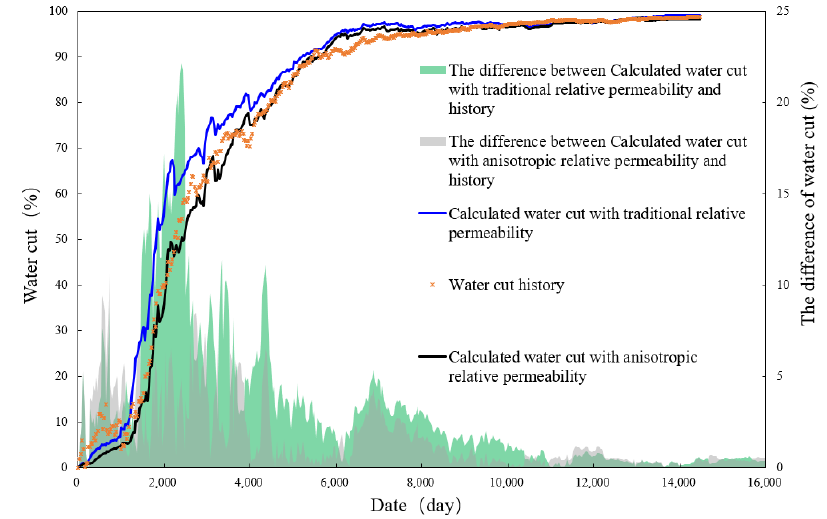
Figure 14. Water cut change with traditional relative permeability and anisotropic relative permeability in the production process of the Cheng 4 South well area.